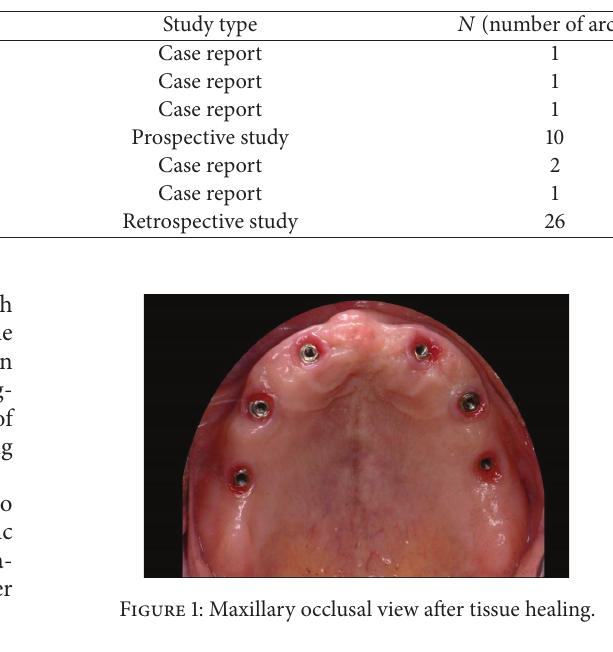
Table 1: Literatures of monolithic zirconia.